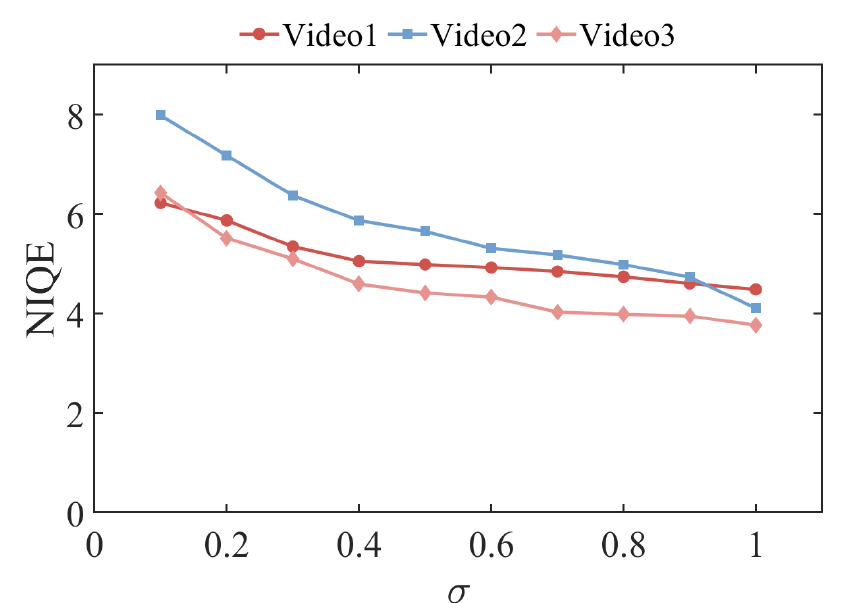
Figure 10. NIQE results for Video 1 (containing the Align 700L V2 obstacle object), Video 2 (containing the DJI F450 obstacle object), and Video 3 (containing the DJI Mavic 2 Pro obstacle object) using the proposed algorithm at different σ values. The lower the NIQE, the better the performance.